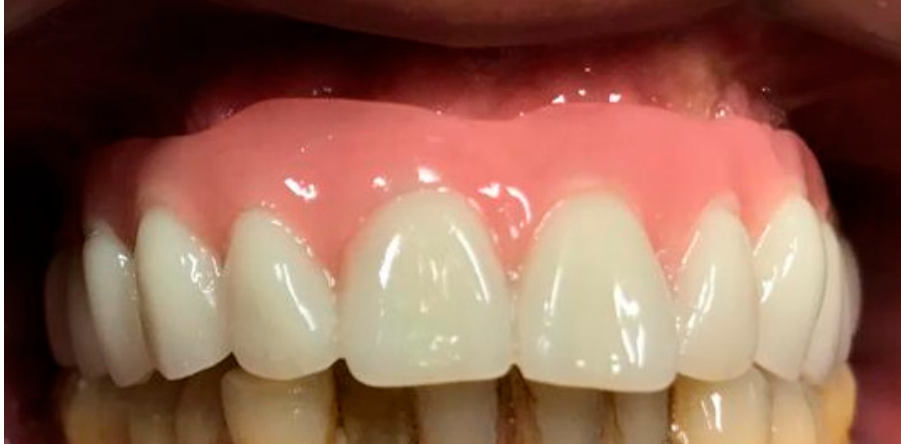
Figure 14. The provisional prosthesis screwed on the M.U.A.